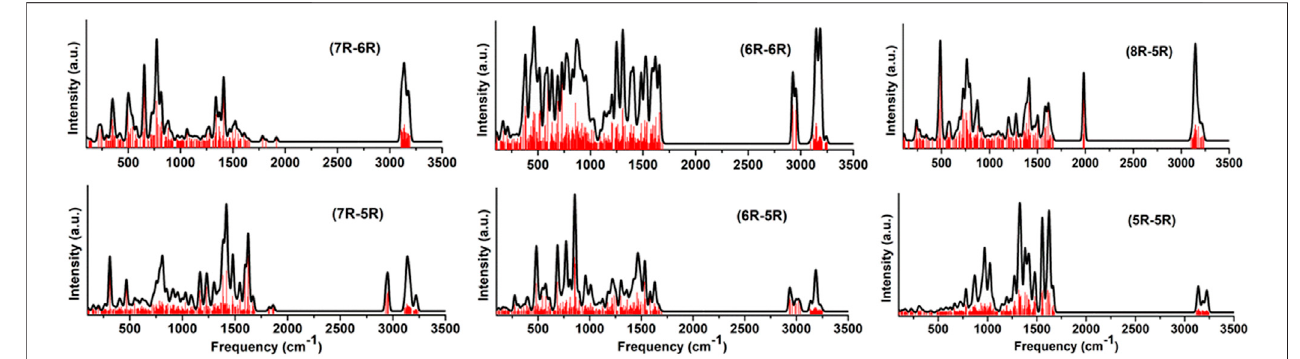
FIGURE 9 | Convoluted vibrational spectra of low-lying carbene/cyclic allene isomers of various groups.